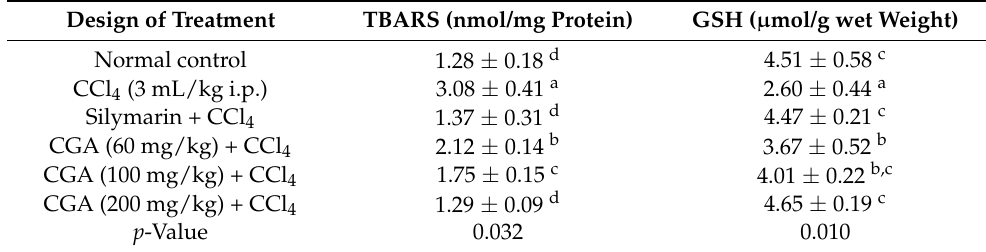
Table 3. Effects of CGA on hepatic TBARS and GSH in CCl 4 intoxicated